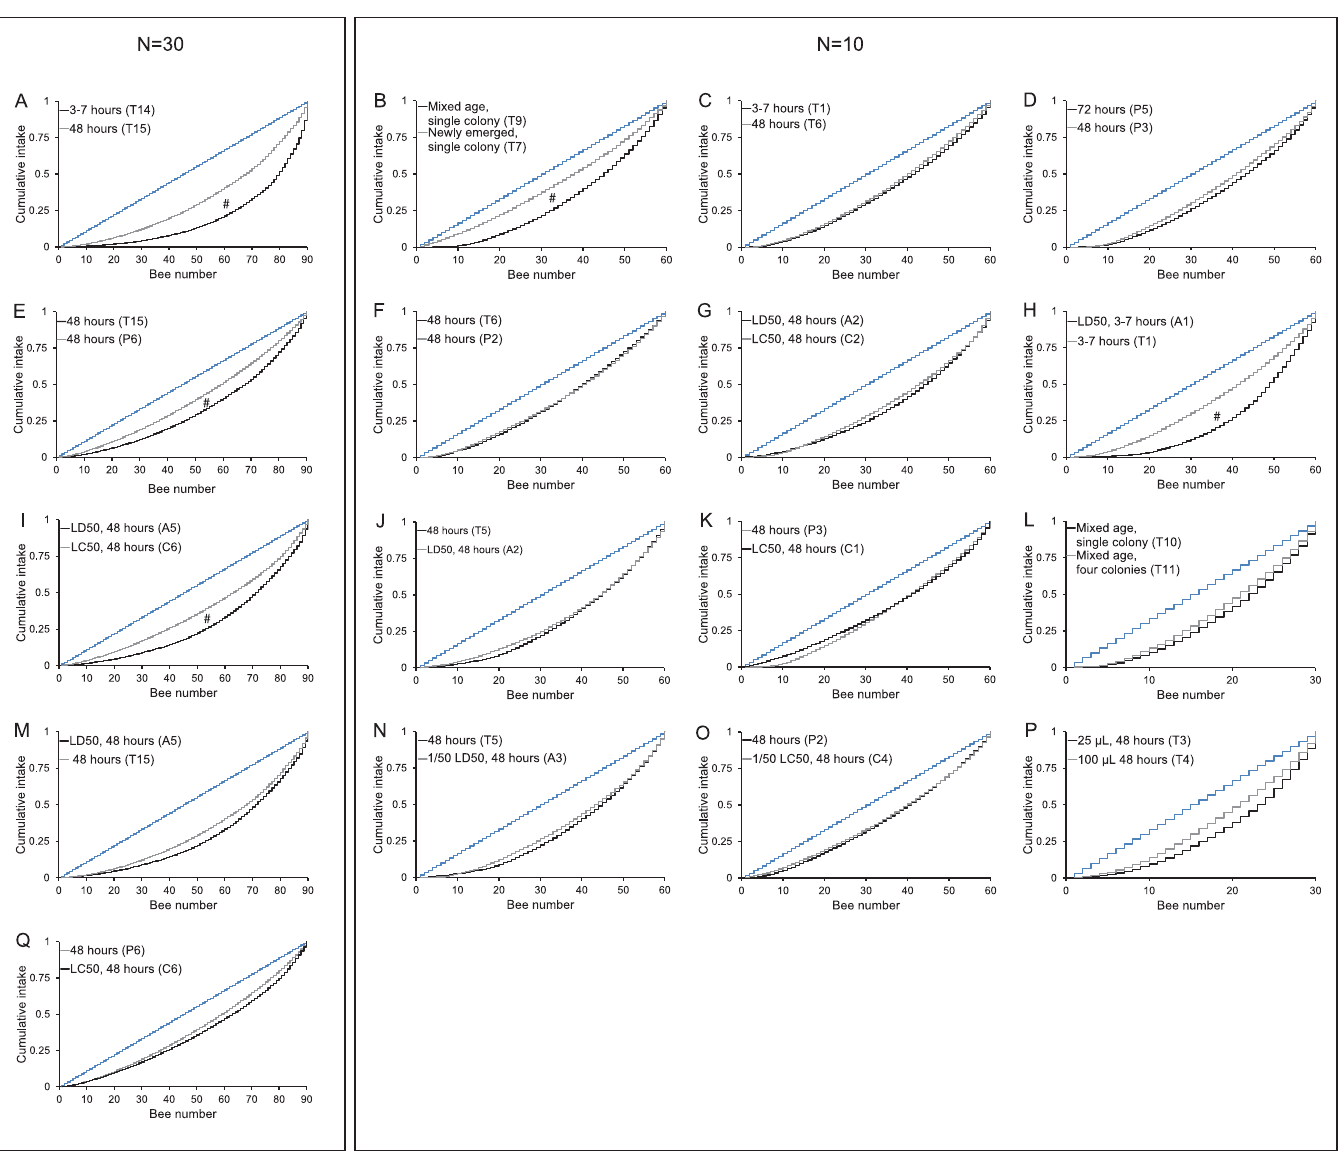
Fig 3. Comparison of cumulative intake of sugar diet between different experimental setups for temporary 1 (T) and permanent 2 (P) feeding regimes without imidacloprid and for acute 3 (A) and chronic 4 (C) feeding regimes with imidacloprid. Pooleddata from replicates of the two different experimental setups are shown (grey and black) referringto an assumed theoretical uniform distribution (light blue). Left column shows all experimental setups with N = 30 bees per cage, right column shows all experimental setups with N = 10 bees per cage. # indicatesstatistically different distributions of food betweenexperimental setups. All experimental setups were statistically different from theoretical uniform distribution. (Kolmogorov-Smirnov test p < 0.05). 1 temporary: test bees initiallyprovidedwith definedamount (25 μ L/100 μ L) of 14 C labelleddiet, followedby unlabelleddiet ad libitum for maintenance 2 acute: test bees initiallyprovidedwith definedamount (25 μ L/100 μ L)of 14 C labelleddiet containingLD 1 / 50 or 50 LD 50 imidacloprid, followedby unlabelled diet ad libitum for maintenance 3 permanent: test bees providedwith 14 C labelleddiet ad libitum 4 chronic: test bees providedwith 14 C labelleddiet containing LD 1 / 50 or 50 LD 50 imidacloprid ad libitum